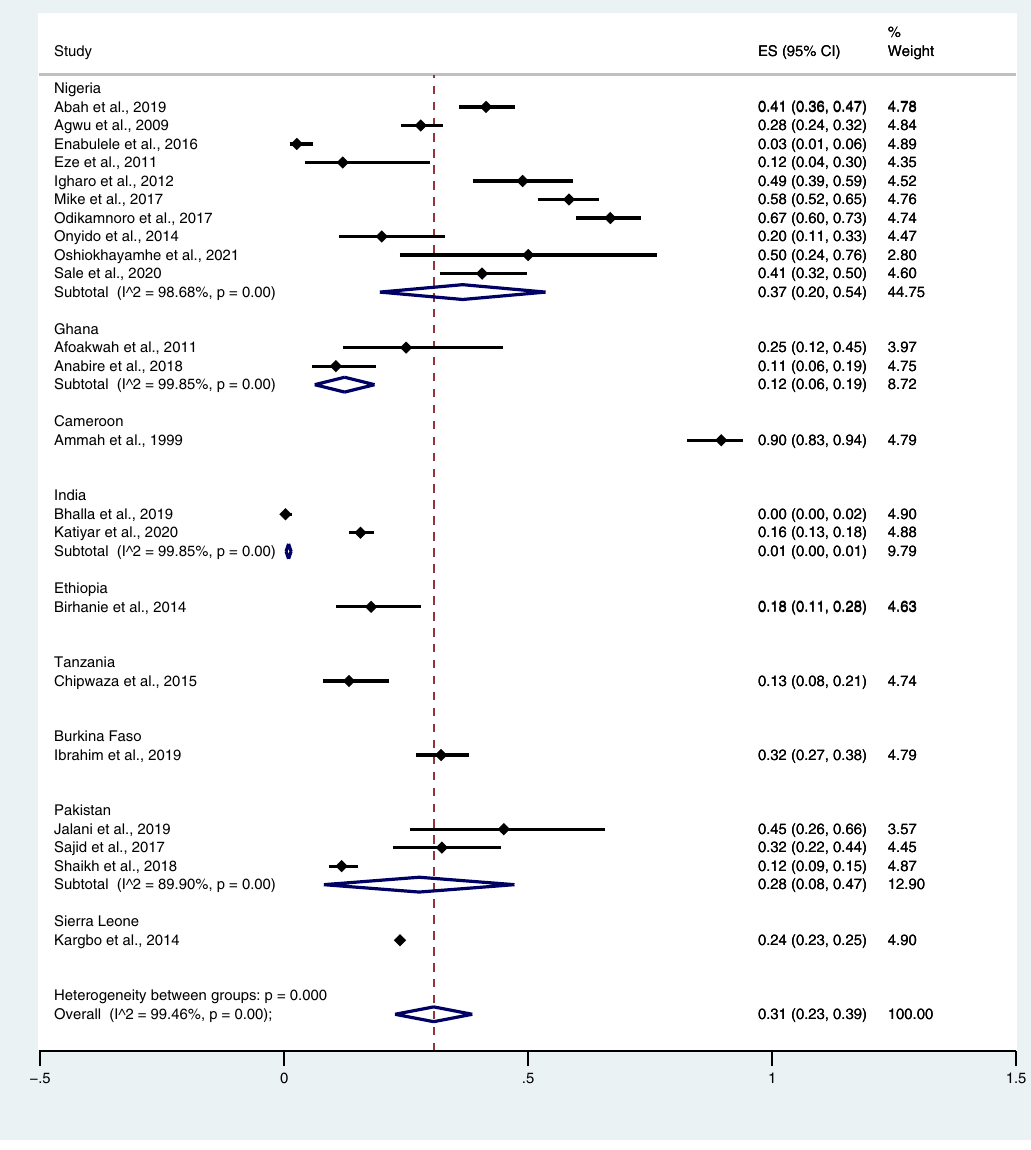
Figure 12. Prevalence of typhoidal/NTS infection among patients with malaria using the Widal test for the identification of Salmonella spp. infection stratified by countries. ES proportion estimate (multiply 100 units for interpreted as prevalence estimate), CI confidence